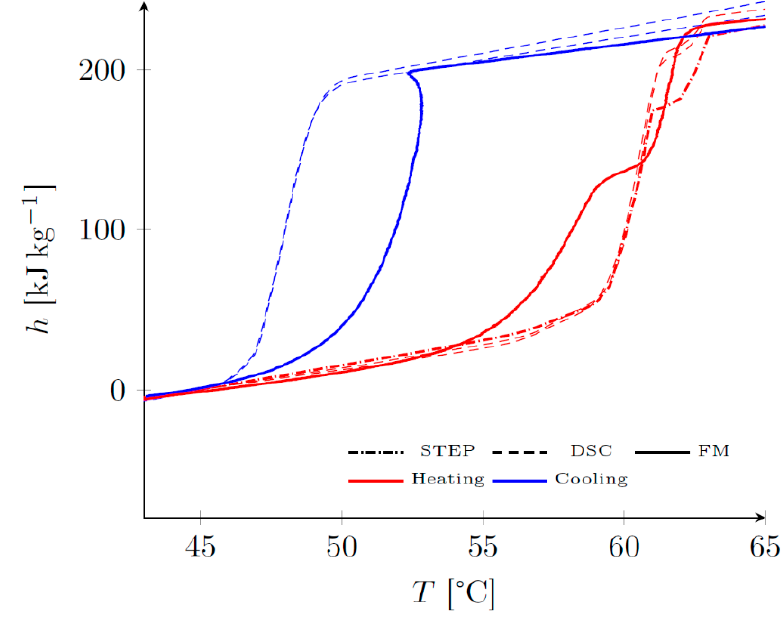
Figure 12. Comparison of the results obtained by the three methods for PEG6000.